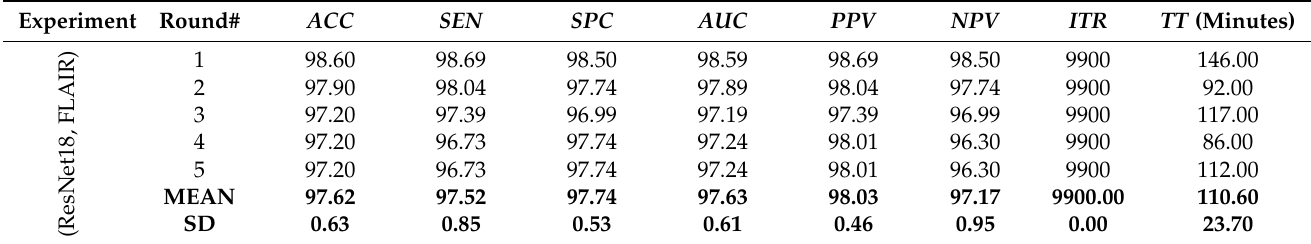
Table A17. Test results of five-folds of the experiment (ResNet18, FLAIR).